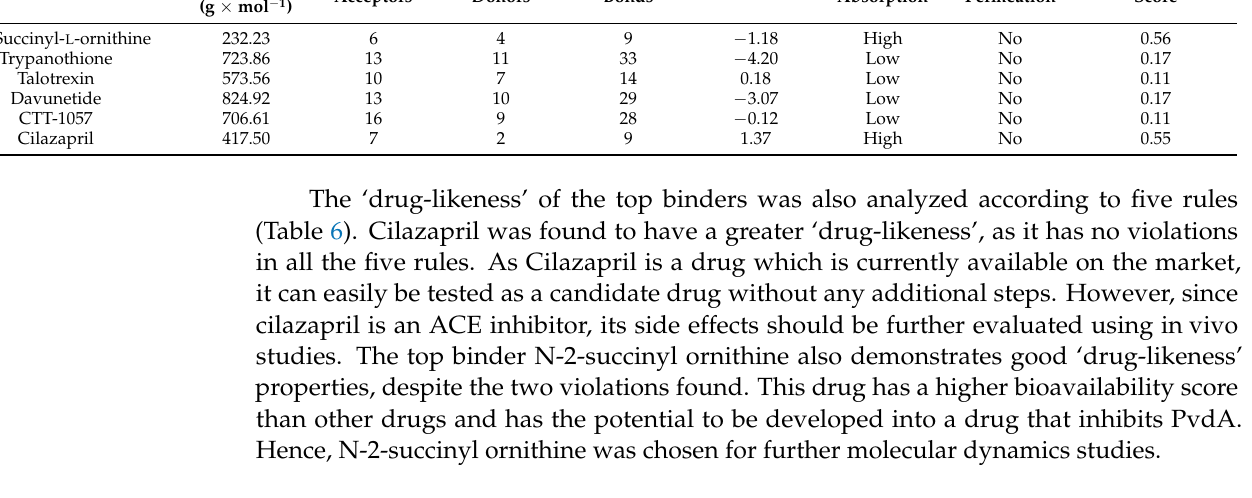
Table 6. Drug-likeness of top